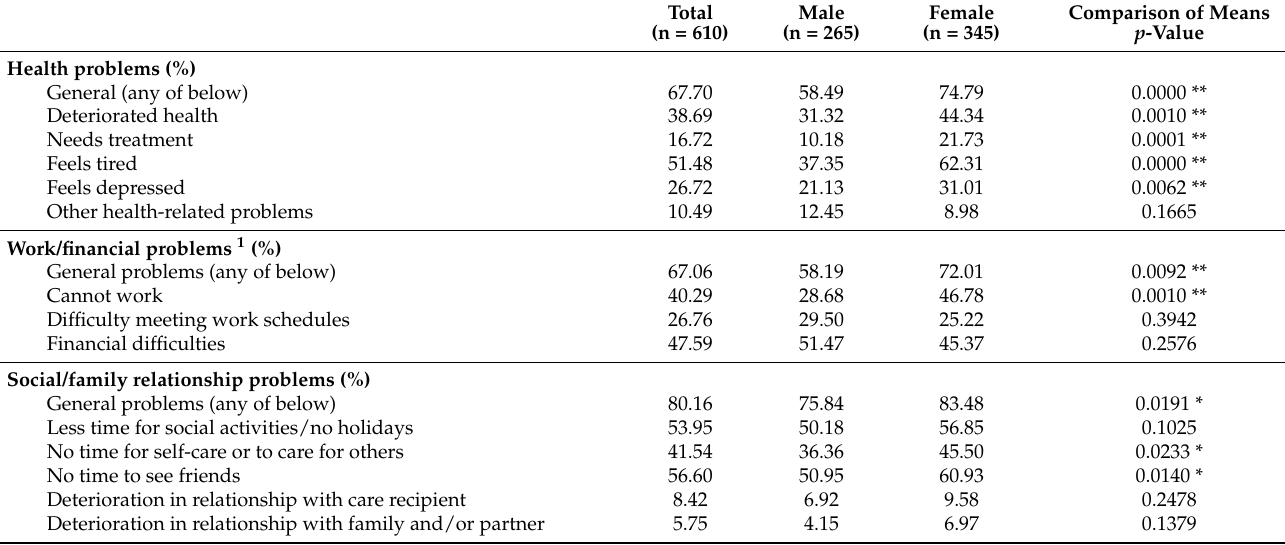
Table 2. Problems attributed to caregiving by male and female caregivers in three dimensions: health, work/finances, and social/family